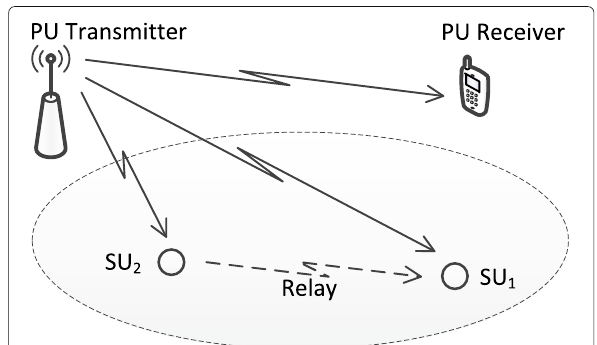
SNR (say SU 2 ) may perform detection with excessive accuracy, while the SU with lower SNR (say SU 1 ) may suffer from numerous missed detections and cause intol- erable interference to PU. Our idea is to let SU 2 sacrifice part of its detection period η T d ( 0 < η < 1 ) to help SU 1 via relay. Then, the whole detection period of SU 2 is divided into two phases, as depicted in Fig.